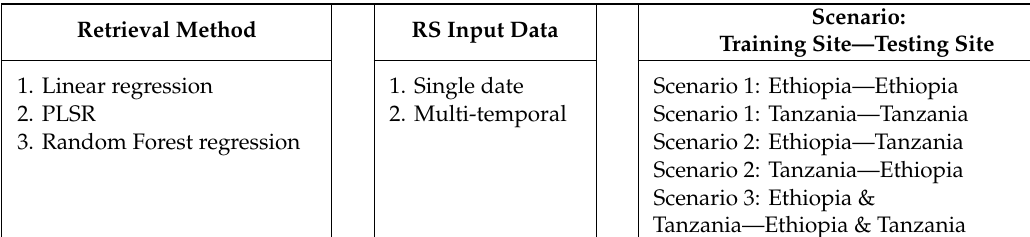
Table 3. Overview of the di ff erent retrieval methods, input data and scenarios. Each of the methods is applied on all three scenarios using both types of RS input